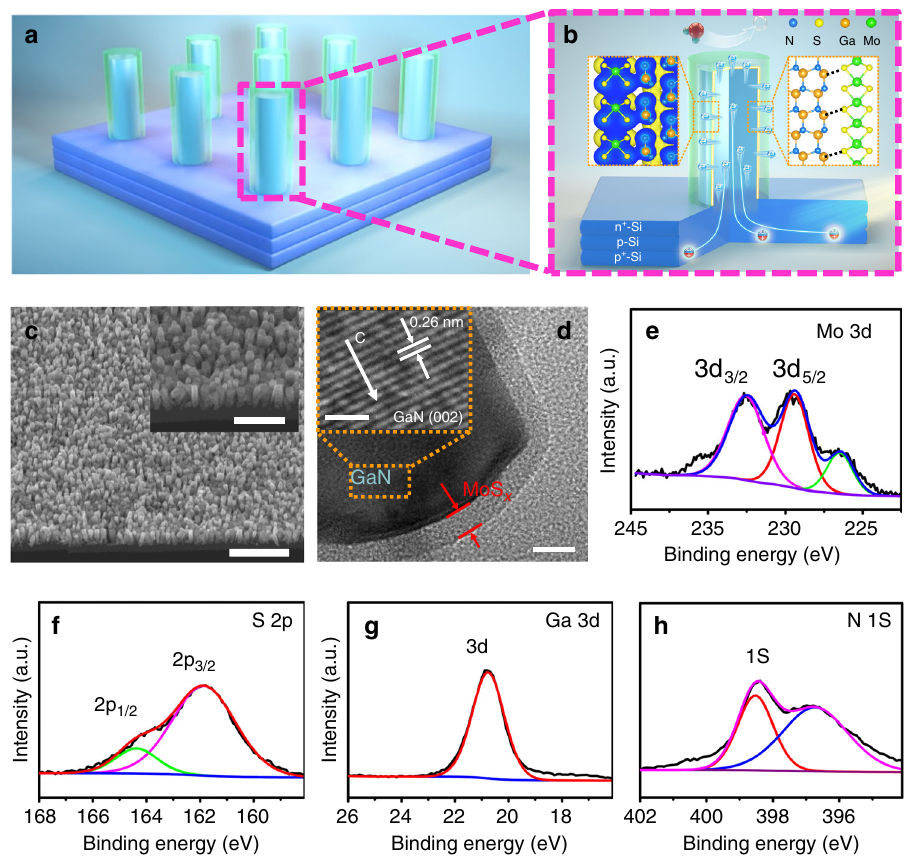
Fig. 2 Schematic illustration and structural characterization. a , b Schematic illustration of the MoS x @GaN NWs/Si heterostructure. GaN nanowire core covered with a uniform shell of MoS x (light-green section) is vertically aligned on planar n + – p junction silicon (the left inset of b shows the unique electronic interaction of MoS 2 /GaN while the right part signi fi es the outstanding geometric matching between MoS 2 and GaN). c 45 o -tilted SEM image of MoS x @GaN NWs/Si. d TEM image of MoS x @GaN nanowire. Inset of d is the HR-TEM image of the GaN core of MoS x @GaN nanowire. High-resolution XPS spectral of e Mo 3d, f S 2p, g Ga 3d, and h N 1s, respectively. Scale bars: c 1 μ m, inset of c 500 nm, d 10 nm, inset of d 2